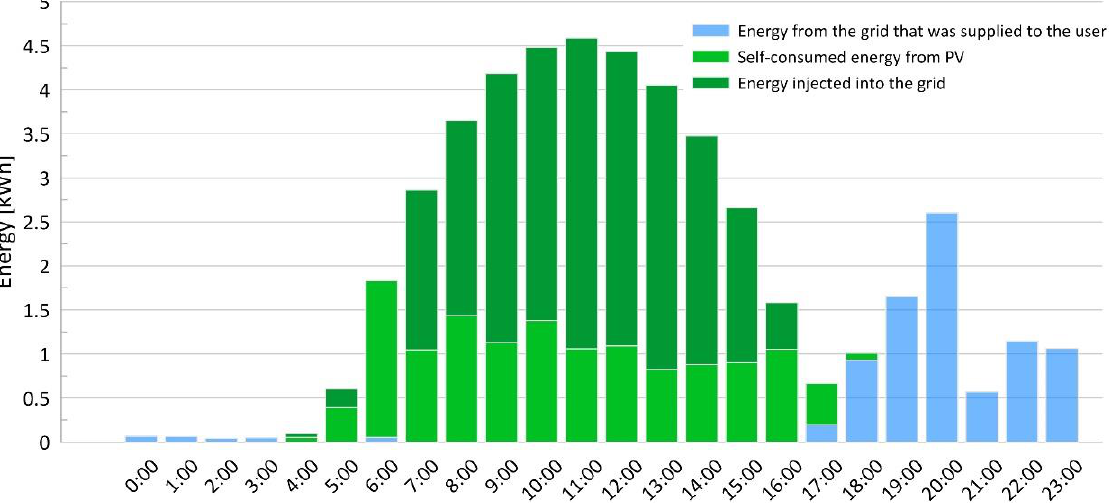
Figure 2. Exemplary hourly results of the simulation for energy distribution for the household. Simulation performed during a sunny day on 26 May 2021.